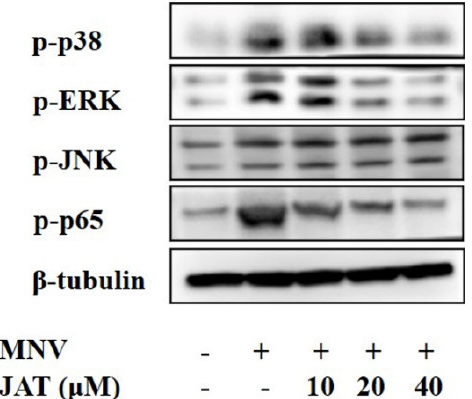
Figure 4. JAT inhibits MNV-infection-induced activation of MAPKs/NF-κB signaling. RAW264.7 macrophages infected with MNV for 24 h and treated with JAT for 48 h were lysed. Cell lysates were immunoblotted for phosphorylated MAPKs (p38, ERK and JNK), p65, and β-tubulin.